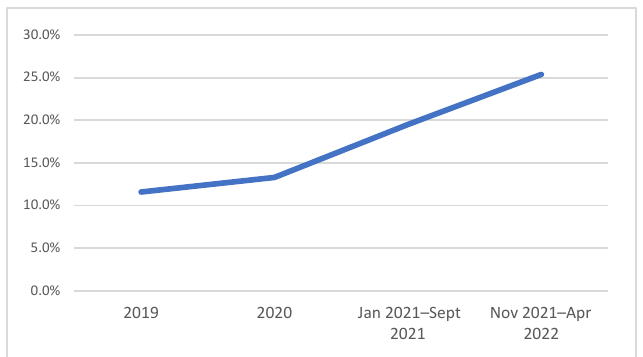
Figure 1. EPDS score ≥ 9 trend in the period 2019-2022.